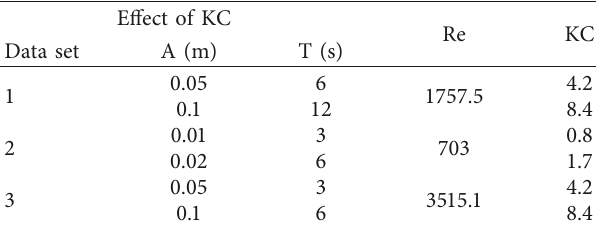
Table 2: Data sets for analysis of effect of KC. Effect of KC